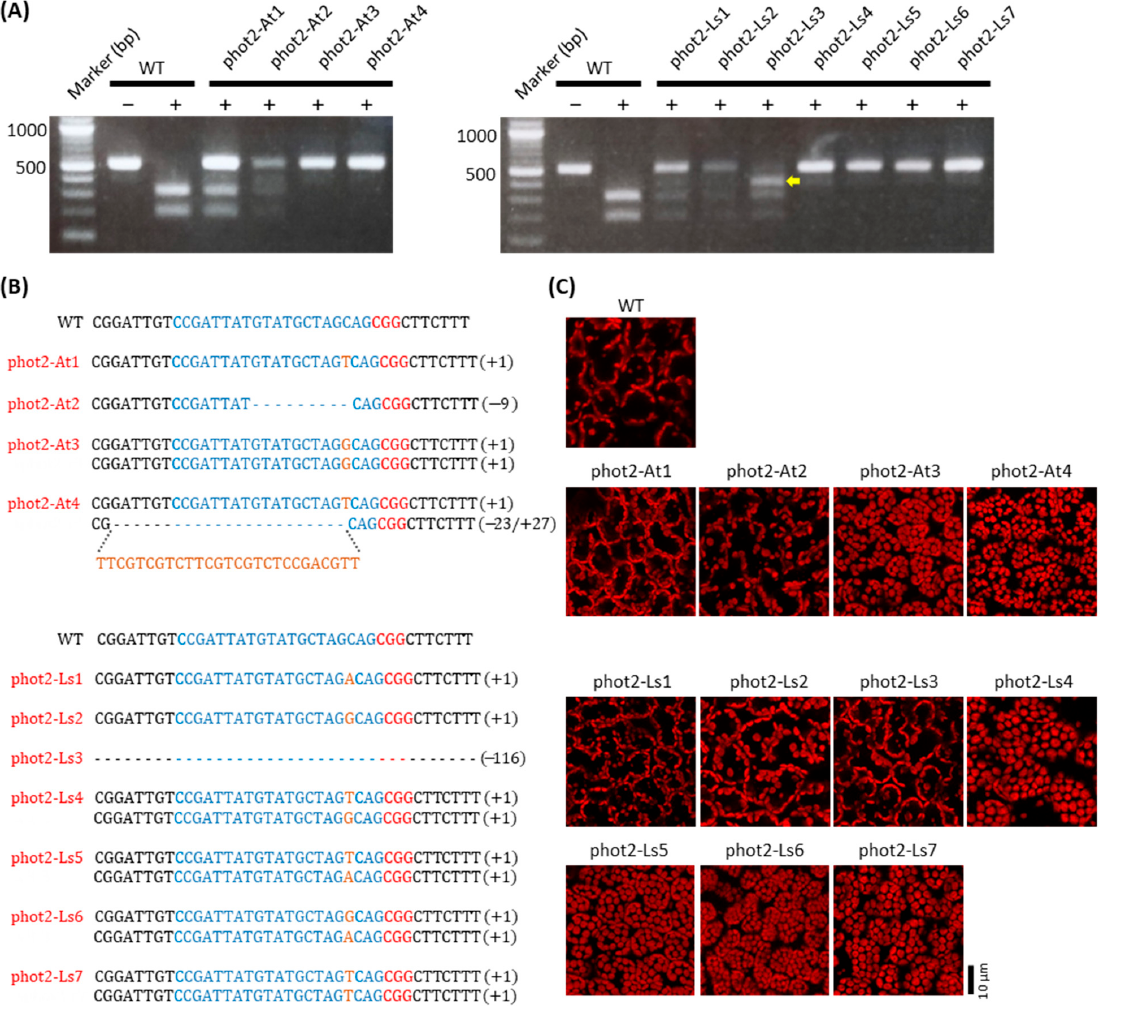
Figure 3. CRISPR/Cas9-induced targeted mutagenesis of LsPHOT2 in lettuce. ( A ) Detection of mutations at the sgRNA361 targeting site of R0 Atphot2 and Lsphot2 transgenic lines. Note that the PCR products of the phot2 mutant lines were resistant to Nhe I digestion. ‘+’ means Nhe I treatment; ‘ − ’ means without Nhe I treatment. The yellow arrow indicates an undigested DNA fragment originating from a 166-bp deletion (see details in B). The marker on the left of each photo indicates the 100 bp DNA ladder. ( B ) Sequence-based detection of phot2 mutations in R0 phot2-At and phot2-Ls transgenic lines. The PAM motif is shown in red, sgRNA361 target sequences are shown in blue, insertions are highlighted in orange, and dashes indicate deletions. ( C ) Chloroplast positioning un- der a high-intensity blue light condition in R0 lettuce phot2 mutant lines generated by CRISPR/Cas9-induced targeted mutagenesis. The leaves of WT and R0 phot2-At and phot2-Ls lines were set on an agar plate containing 0.5% gellan gum and irradiated with high-intensity blue light (50 μ mol m − 2 s − 1 ) for 2 h. Chloroplast positioning was observed using a confocal laser scanning microscope. Scale bar = 10 μ m.